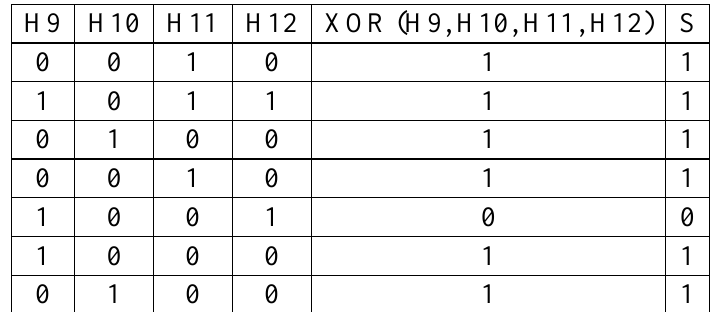
Table 2. Error location